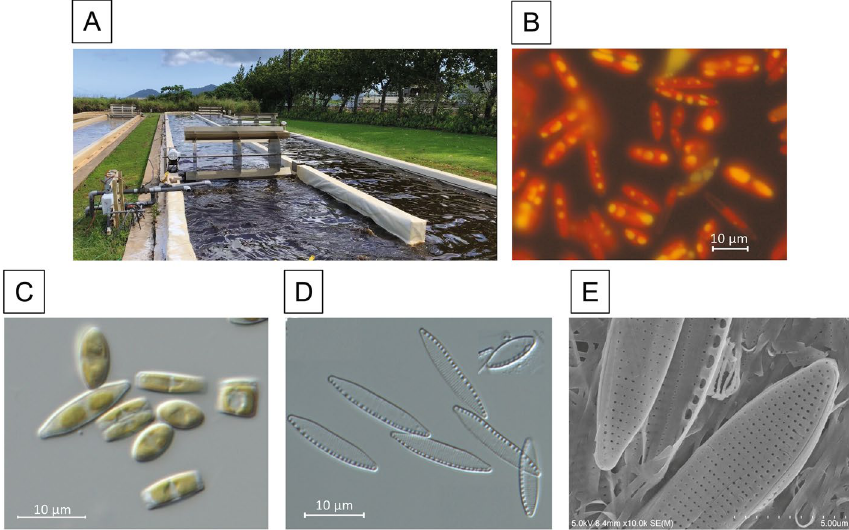
Figure 1. Outdoor culture and cellular morphology of N. inconspicua str. hildebrandi. Panel A , N. inconspicua cultivated in a paddle wheel pond at the Kauai Algae Farm operated by Global Algae Innovations Inc; B , fluorescence micrograph of cells stained with Nile Red, showing non-polar lipid droplets (yellow) and chlorophyll autofluorescence (red); C , differential interference contrast micrograph (DIC) of live cells in valve view and girdle view, showing elongated chloroplasts, small lipid droplets, and centrally located nucleus; D , DIC micrograph of acid cleaned valves showing lanceolate frustule shape and arrangement of striae and fibulae; E , scanning electron micrograph showing structural details of striae and